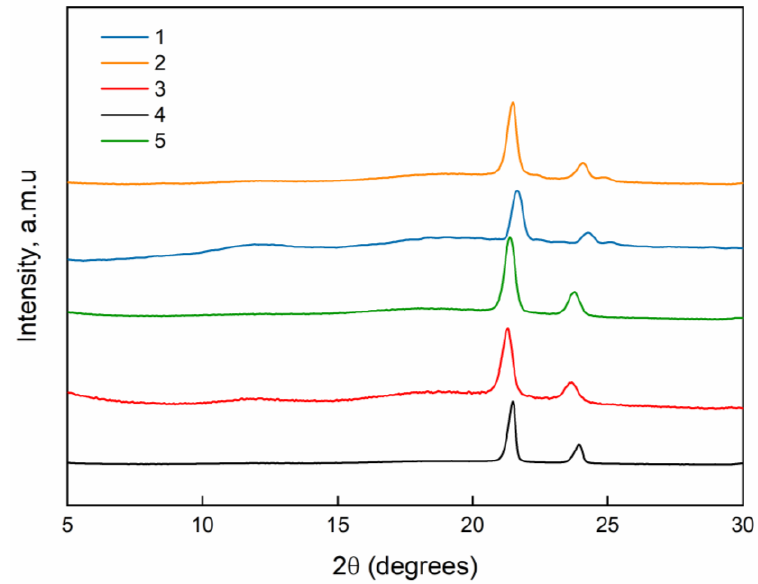
Figure 4. XRD spectra of the samples reported in Table 1.